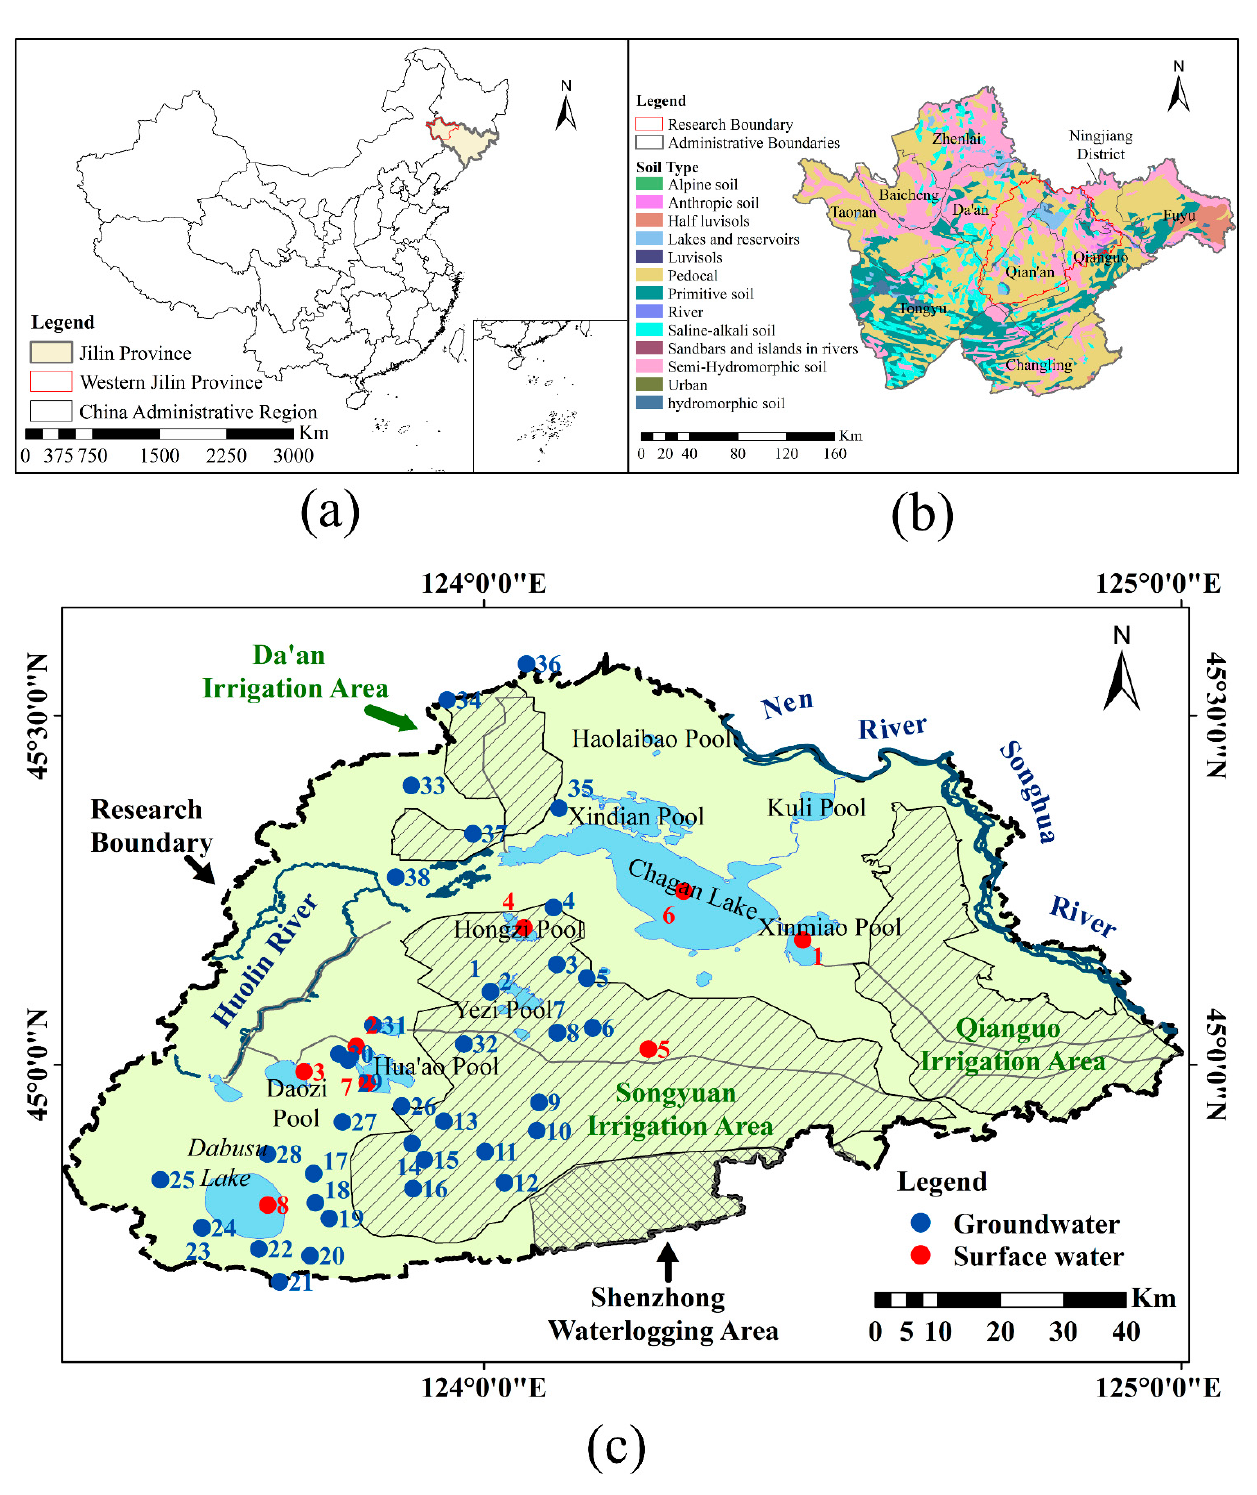
Figure 1. Distribution map of sampling sites. ( a ) Location of western Jilin Province in China; ( b ) soil types and the location of study area in western Jilin; ( c ) sampling sites in Chagan Lake Catchment.